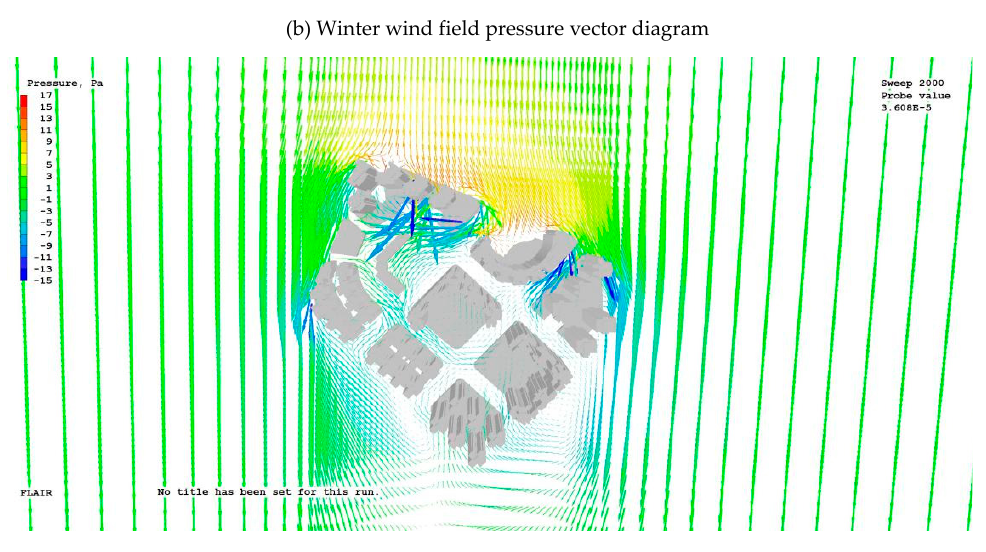
Figure A5. Winter vector diagram, winter wind field pressure vector diagram, and winter vector diagram of wind field flow velocity at 10 m height.